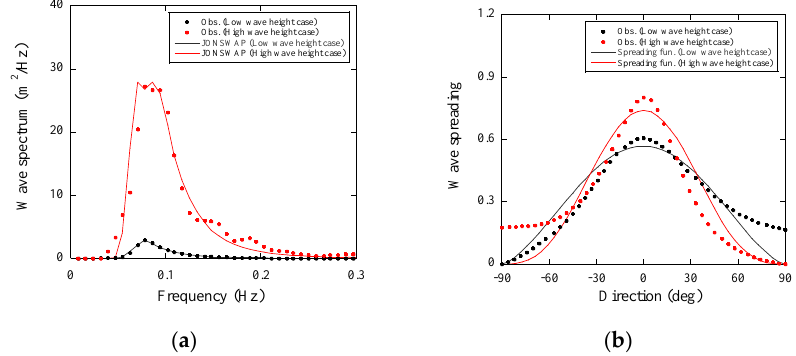
Figure 16. Comparison of the ( a ) frequency spectrum and ( b ) directional spreading between the observed and simulated wave at low and high wave height cases.